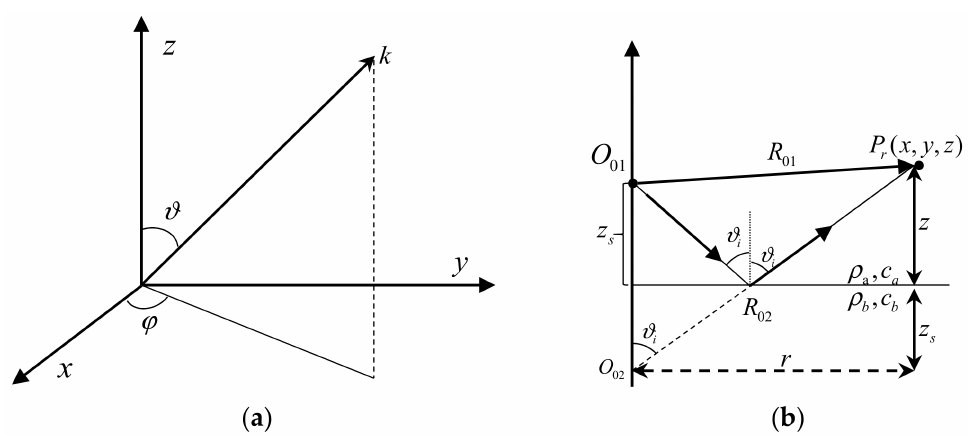
Figure 2. Diagram of the interaction between plane wave and liquid–liquid interface: ( a ) decomposi- tion of the wavenumber vector k in three-dimensional (3D) space; ( b ) sound reflection of plane waves on the liquid–liquid